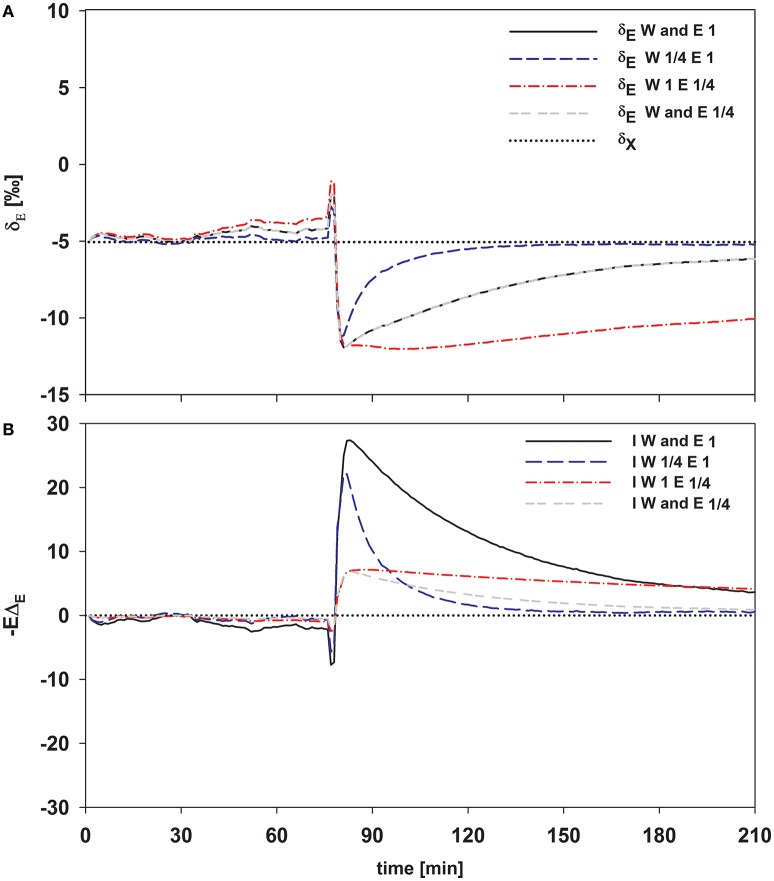
Time series of modeled δE (A) and the transpirational isoflux (B) of Plantago lanceolata. To disentangle the temporal dynamics of the impact of W and transpiration rate, E was set to one and 1/4 of the observed value and W was set to 14.4 and 3.6 mol m−2 (which is 1/4 of 14.4). These values span the values for E and W observed in this study pooled over all species.